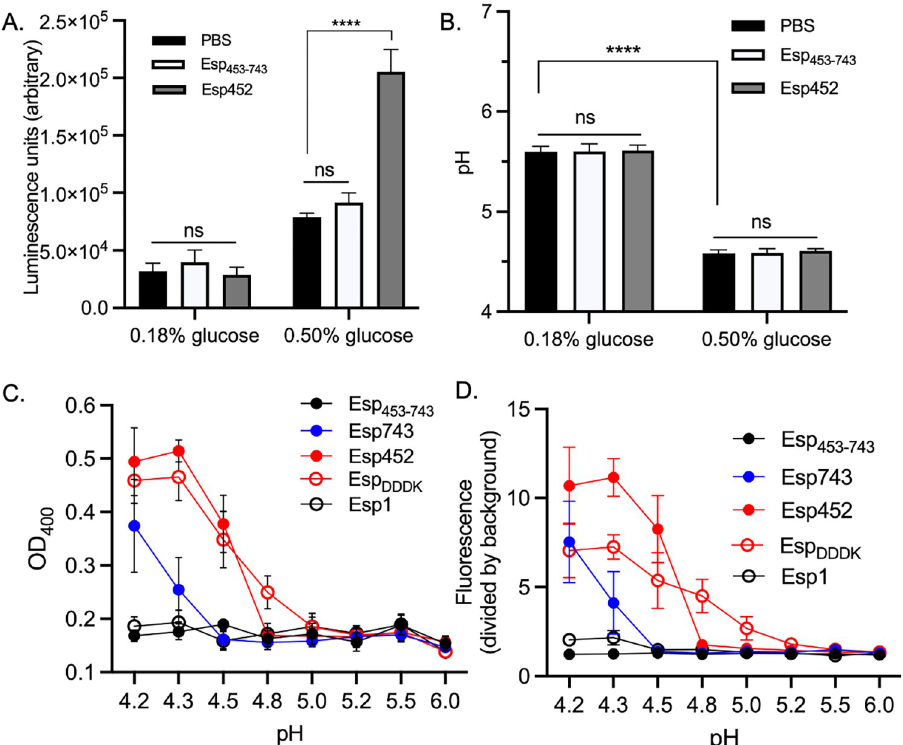
Fig 3. Low pH promotes biofilm strengthening by Esp452. A. Luminescence of MMH594b ( Δ esp ) biofilms grown in either 0.18% or 0.50% glucose, and with PBS, Esp 453-743 , or Esp452. The experiment was conducted with triplicates. Samples from three independent experiments were compared by 2-way ANOVA and Tukey’s test. ���� p < 0.0001. B. The pH of biofilm cultures of MMH594b grown in TSB with 0.18 or 0.50% glucose, and with Esp452, Esp 453-743 , or PBS. The experiment was conducted with triplicates. Samples from three independent experiments were combined and compared by 2-way ANOVA and Tukey’s test. ���� p < 0.0001. C. OD 400 of Esp fragments (25 μ g) incubated in sodium citrate buffer at the indicated pH for 24 h. Experiments were conducted with duplicates. Samples from three independent experiments were combined and the SEM is indicated with error bars. D. Fluorescence of Thioflavin T incubated for 24 h with Esp fragments (25 μ g) in sodium citrate buffer at the indicated pH. Experiments were conducted with duplicates. Samples from three independent experiments were combined and the SEM is indicated with error